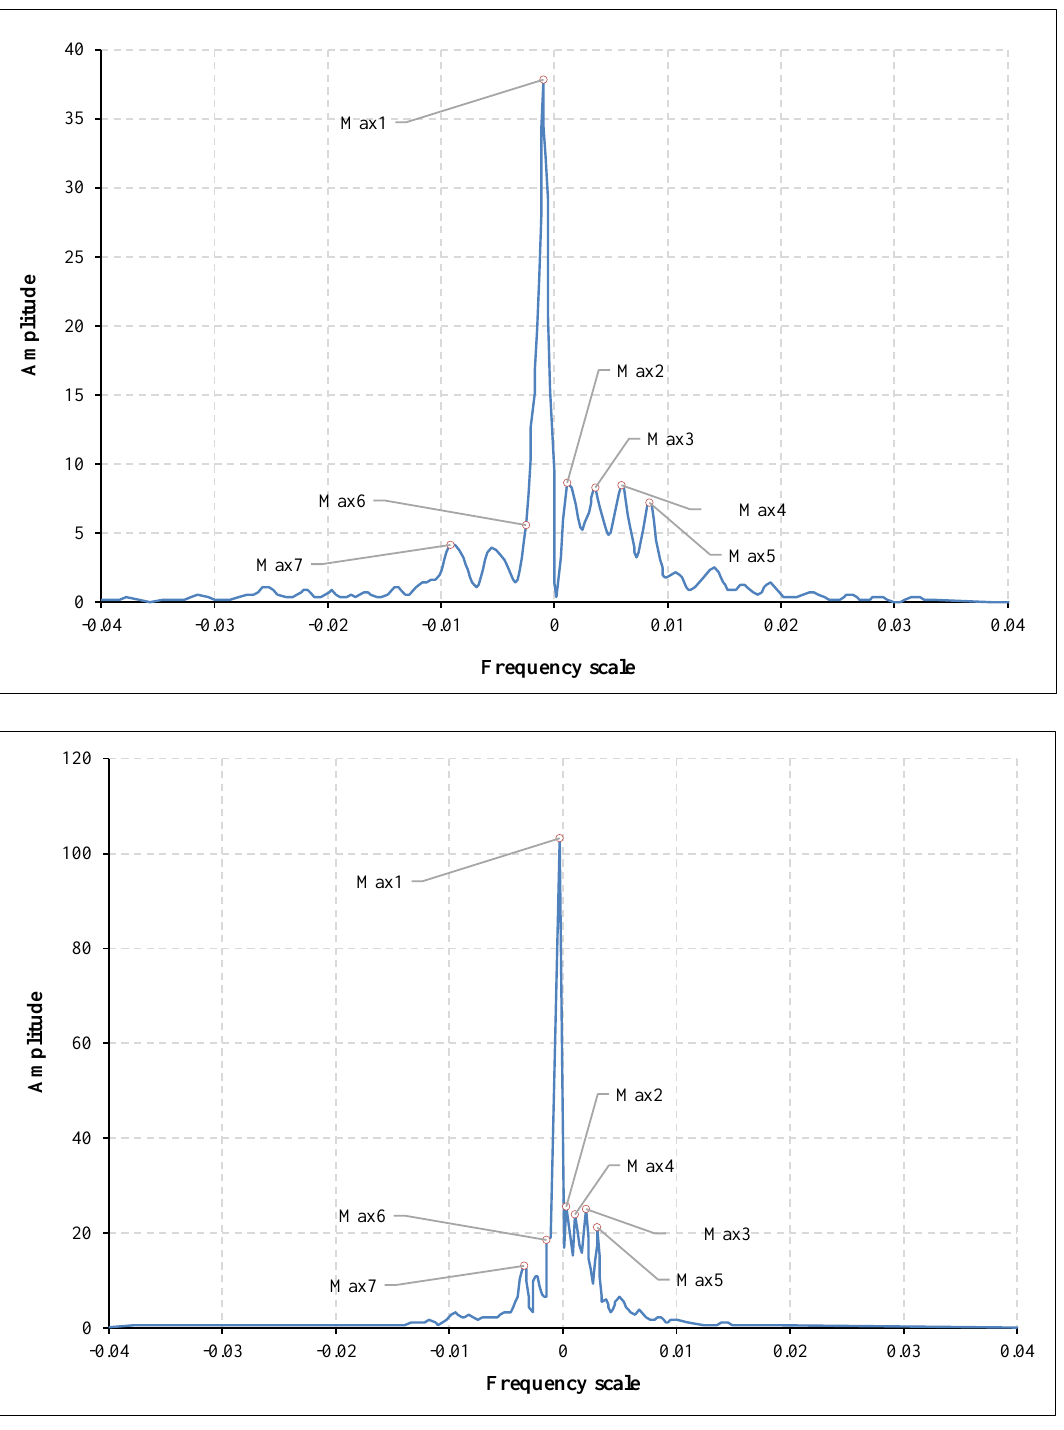
Figure 14. Spectra of the segment boundary (a) before modification, and (b) after modification Figure 15-a shows graphs of the parametric curves x = f 1 ( t ) and y = f 2 ( t ), corresponding to the initial and restored image by 51 descriptors. Figure 14-b shows the same curves but corresponding to the modified image spectrum. It can be seen that Figures 15-a and 15-b differ only in scale. The scale on the abscissa axis increased 2.8 times; the scale increased in the same ratio on the ordinate axis in Figure